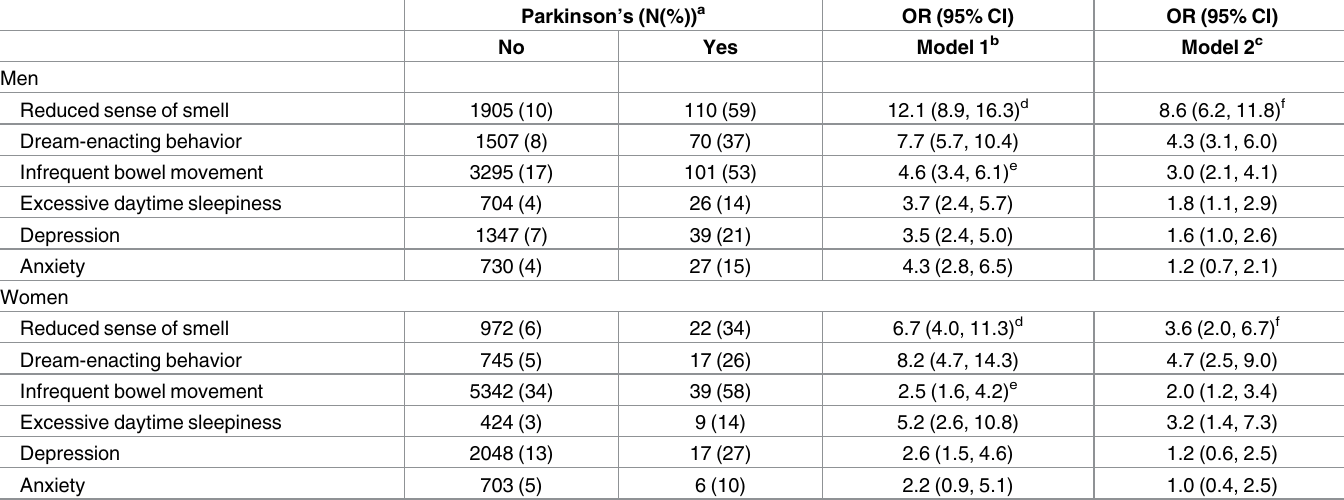
Table 2. Non-motor symptoms and Parkinson’s disease in the Agricultural Health